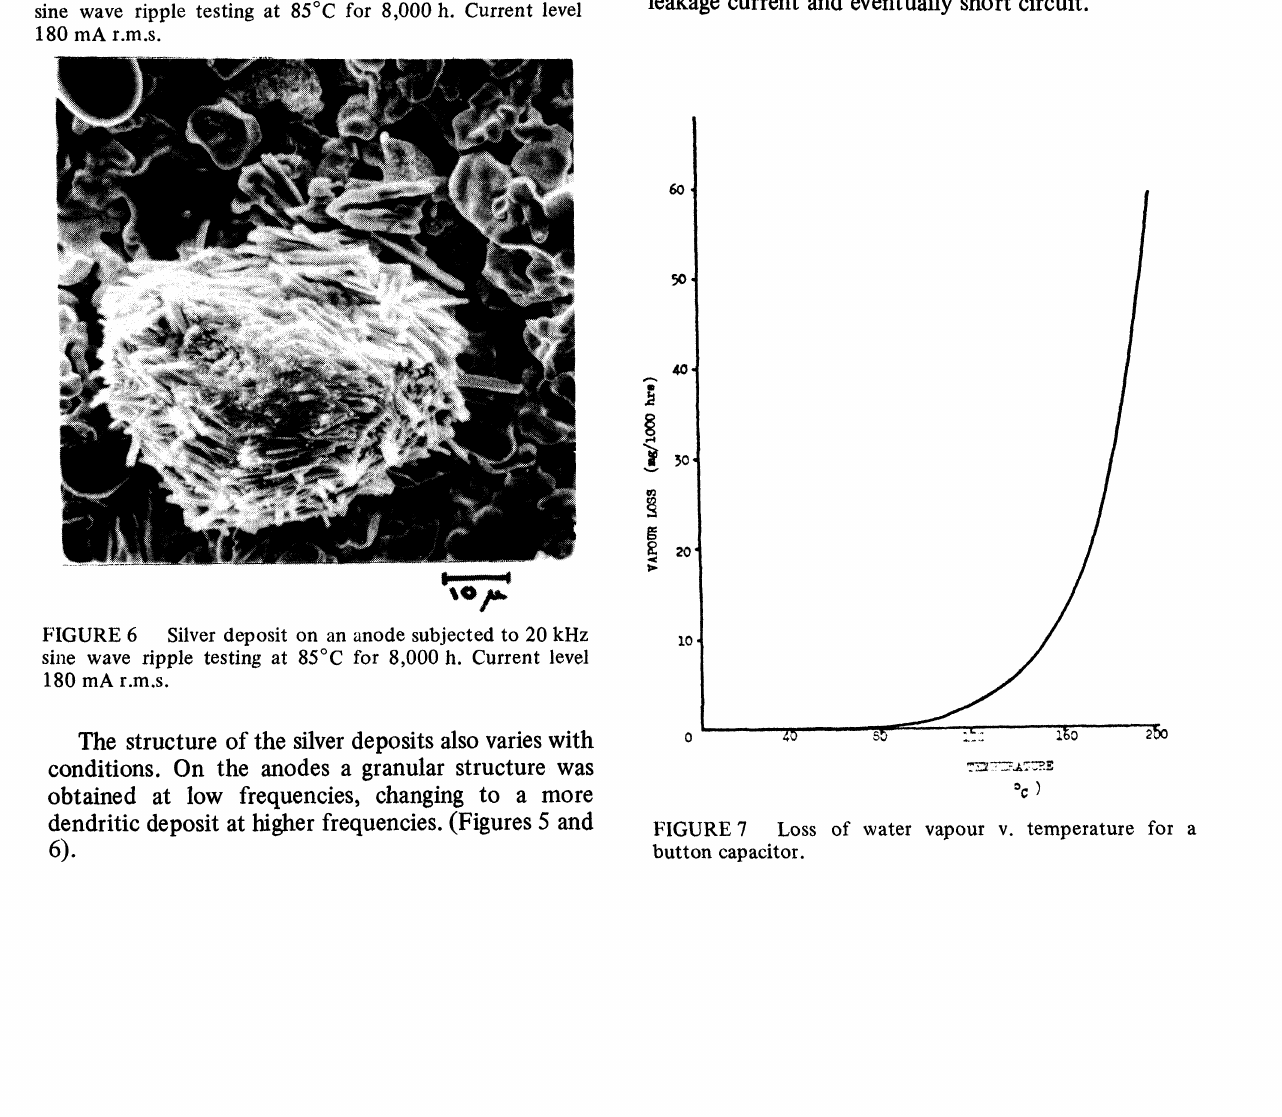
Silver deposit on an anode subjected to 50 Hz sine wave ripple testing at 85C for 8,000 h. Current level 180 mA r.m.s.